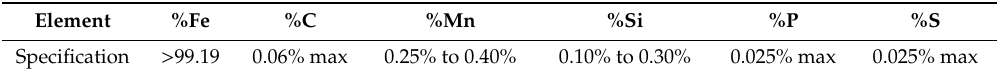
Table 5. Chemical composition of the steel fibers used in this